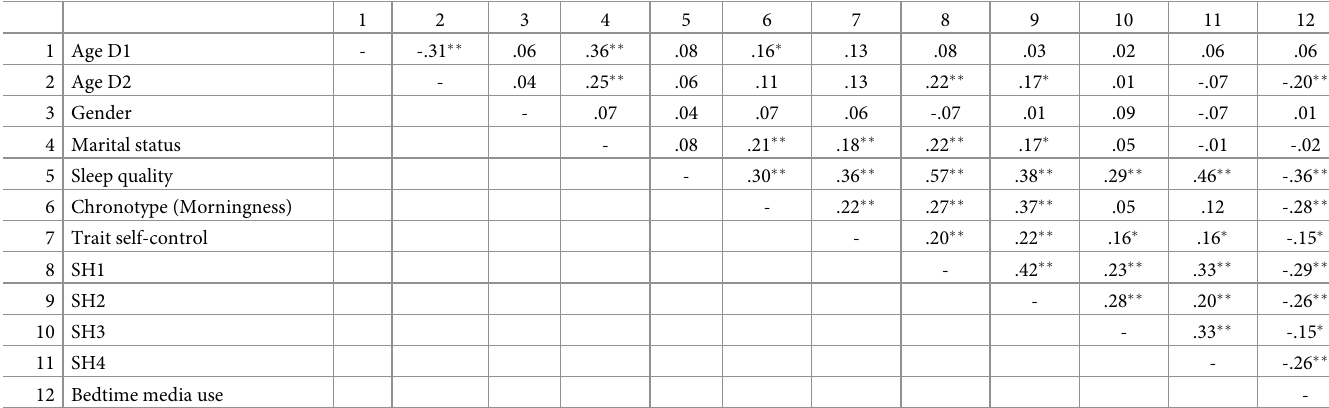
Table 4. Bivariate associations between study